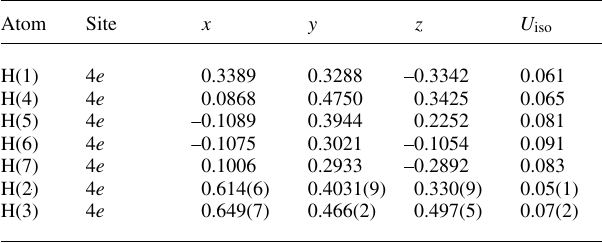
Table 2. Atomic coordinates and displacement parameters (in Å 2 )